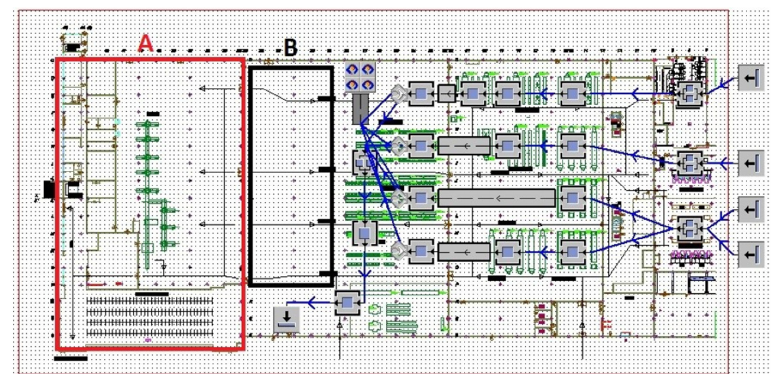
Figure 12. Unused space in the production hall.